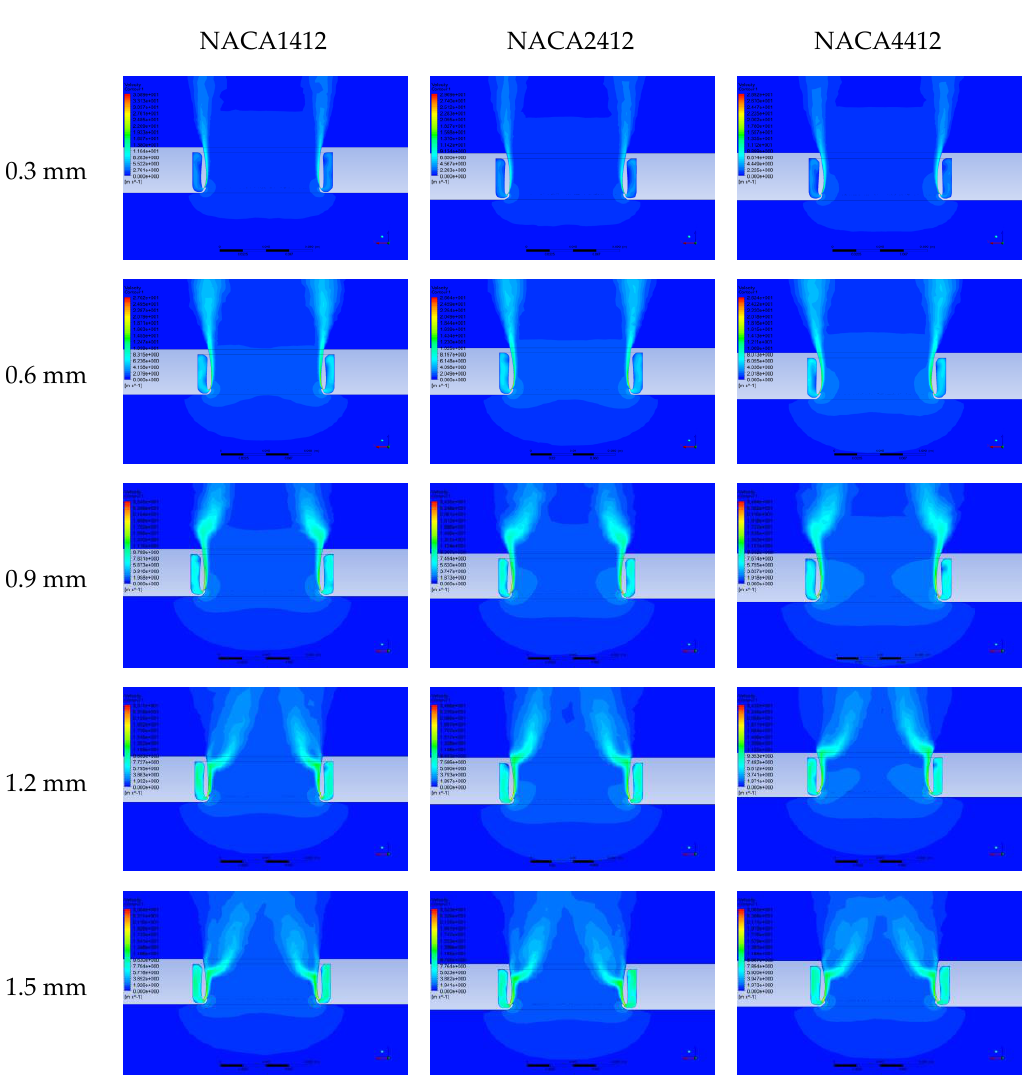
Figure 10. Flow velocity distributions, with fixed airfoil thickness and various airfoil cambers and outlet slit sizes.